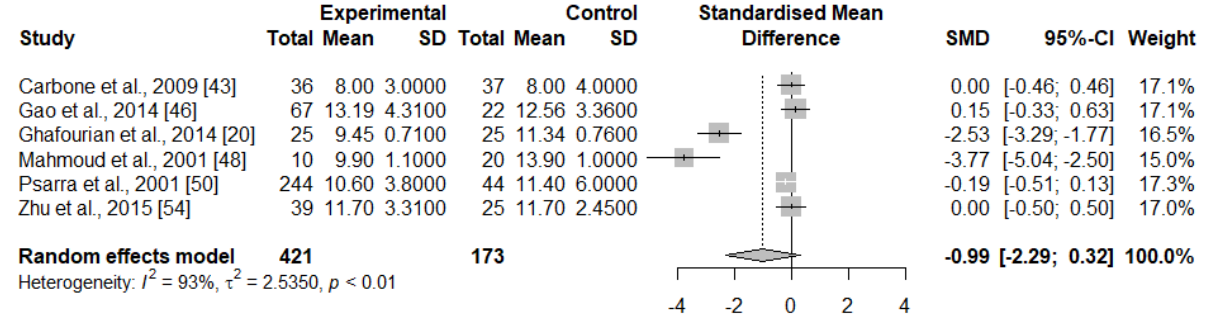
Figure 3. Random-effect meta-analysis for the levels of endometrial B cells in IRPL and HC women.